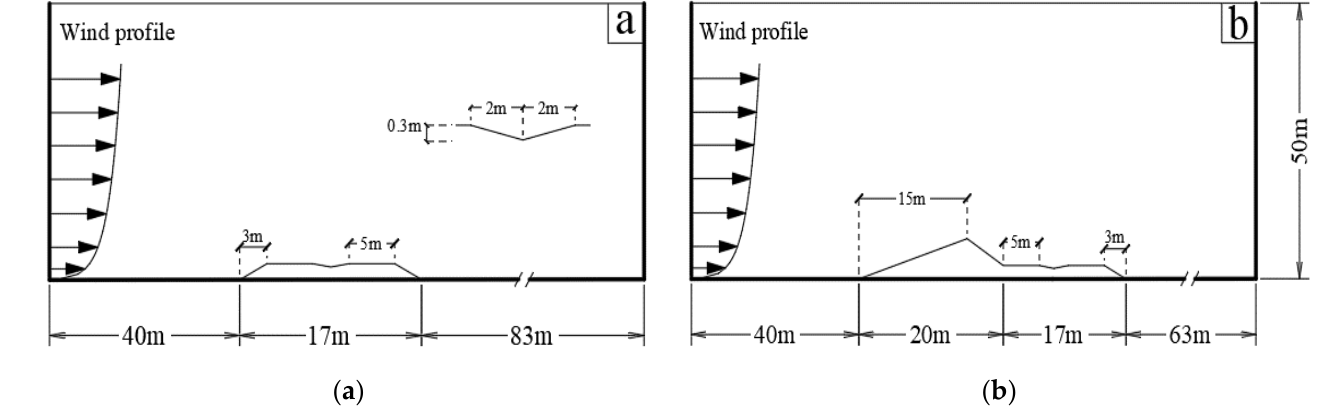
Figure 7. Flow field simulation domain—flat terrain ( a ) windward dune; ( b ) subgrade.